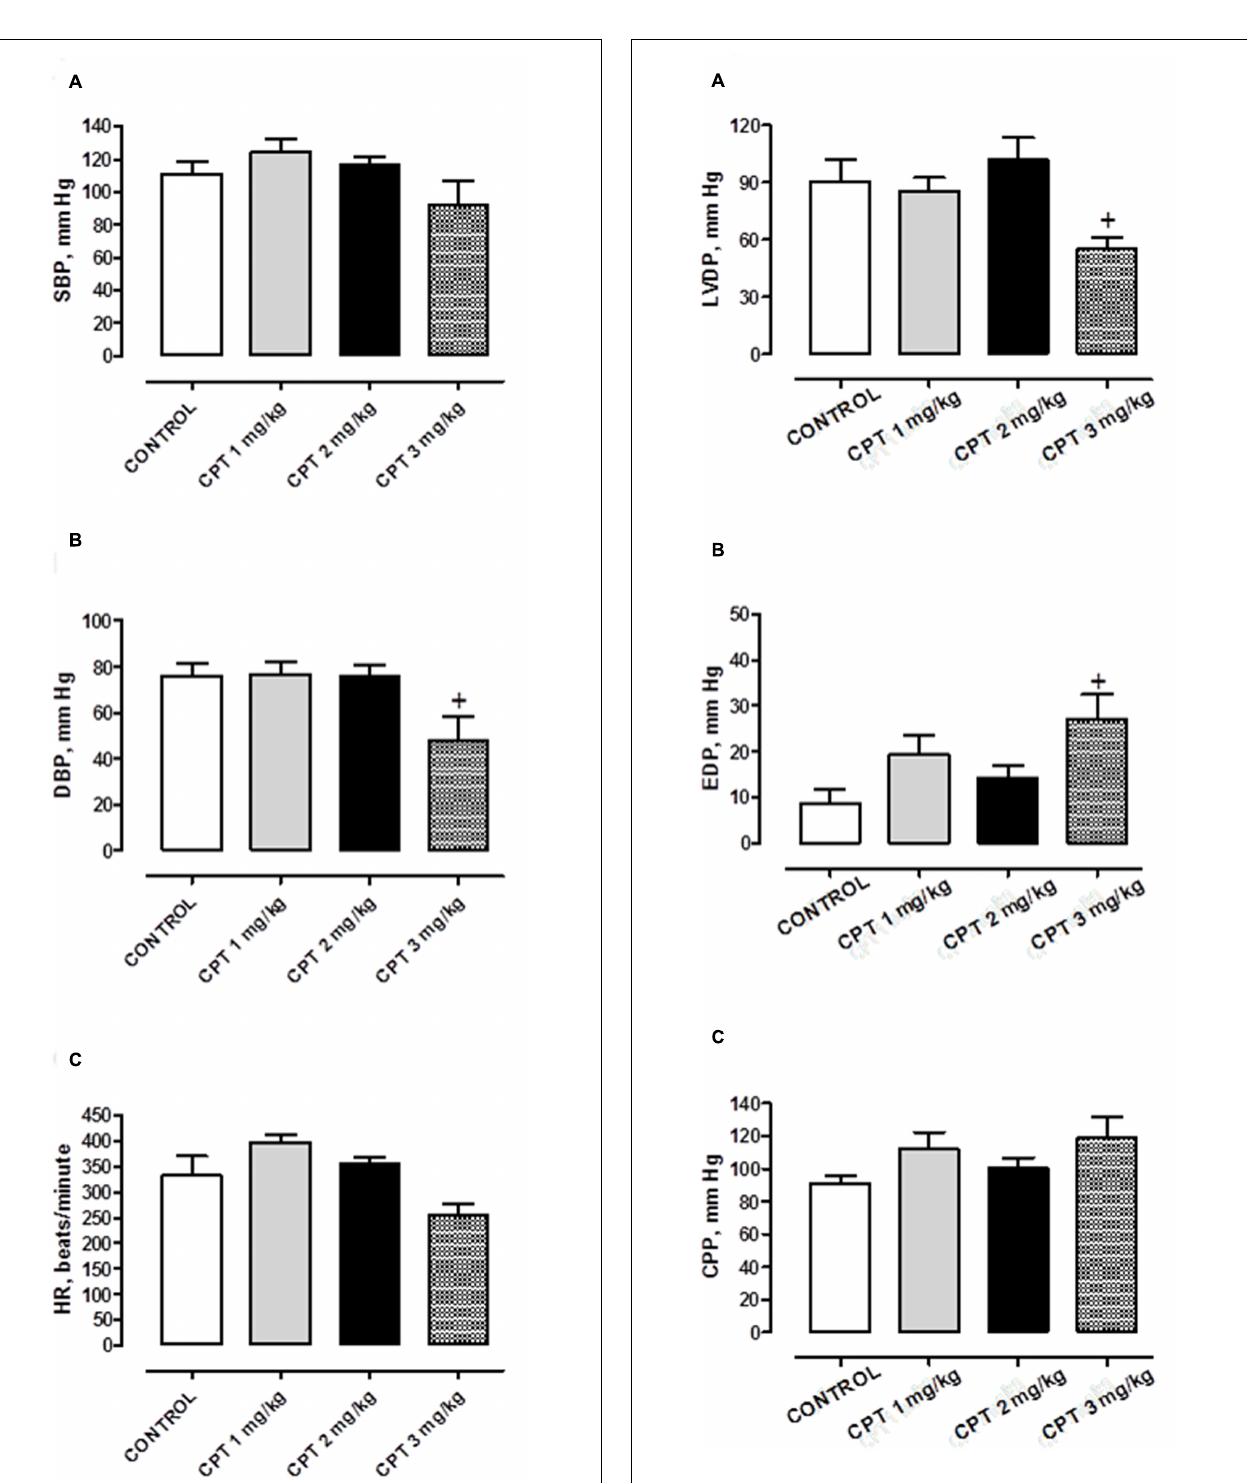
FIGURE 2 | Basal values of (A) left ventricular developed pressure (LVDP), (B) end diastolic pressure (EDP), and (C) coronary perfusion pressure (CPP) of isolated hearts from animals chronically treated with saline (CONTROL) or cisplatin (CPT) 1 mg/kg, 2 mg/kg or 3 mg/kg. Data represent the mean ± SEM, n = 10–15 preparations per experimental group. A one-way ANOVA followed by Bonferroni/Dunn post hoc test was used for statistical analysis ( + P < 0.05, CPT 3 mg/kg vs.